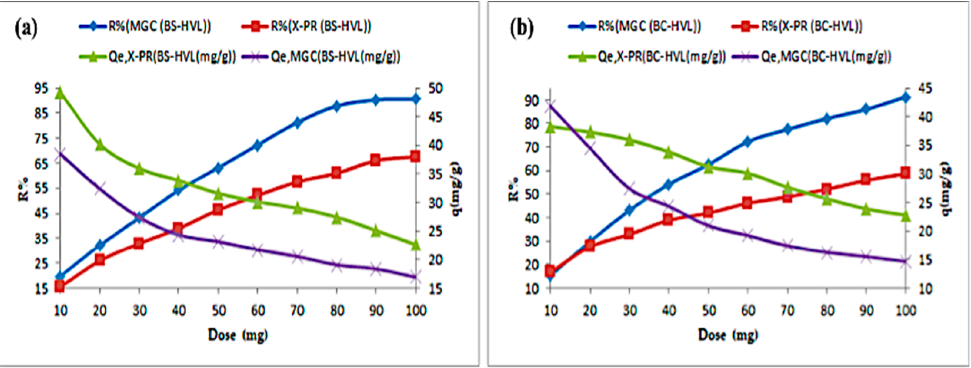
Figure 12. Effect of the amount of adsorbent BS-HVL ( a ) and BC-HVL ( b ) on the adsorption of dyes X-PR and MGC (t = 90 min; T = 21 ± 1 °C; C0 = 50 mg L − 1; stirring speed 150 rpm and pH = 7 ± 0.3).